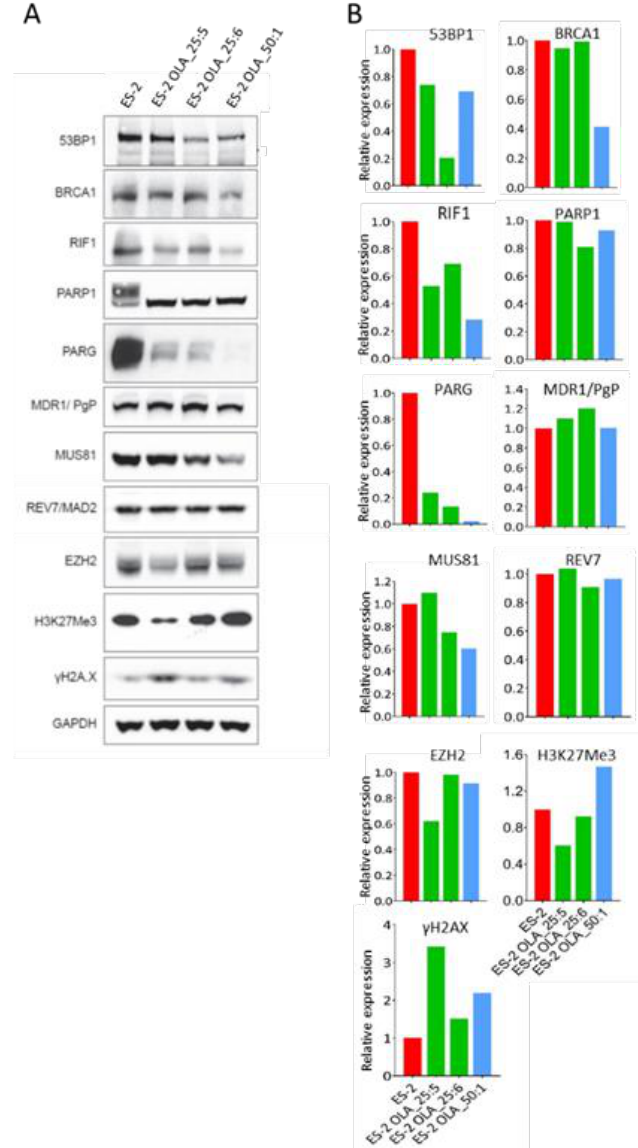
Figure 3. Changes in protein levels in ES-2 derived olaparib-resistant clones. Protein lysates were made from the ES-2 parent grown in normal medium and ES-2 clones maintained continuously under olaparib selection. ( A ) Western blots for 53BP1 (mol. wt. 214 kDa), BRCA1 (220 kDa), RIF1 (265 kDa), PARP1 (116 kDa), PARG (111 kDa), MDR1 (170 kDa), MUS81 (62 kDa), REV7 (24 kDa), EZH2 (85 kDa), H3K27Me3 (15 kDa), γH2AX (14 kDa) from ES-2 and three olaparib-resistant ES-2 derived clones, with GAPDH (37 kDa) as loading control. ( B ) Histograms showing levels of the different proteins in each clone, corrected for differences in loading control, and expressed relative to the level in the ES-2 parent. ES-2 parent shown in red. ES-2 OLA_25:5 and ES-2 OLA_25:6, resistant to 25 µM olaparib, are shown in green. ES-2 OLA_50:1, shown in blue, is resistant to 50 µM AZD1775. Note that the apparent reduction in levels of BRCA1 in clone ES-2 OLA_50:1 most likely reflects a problem